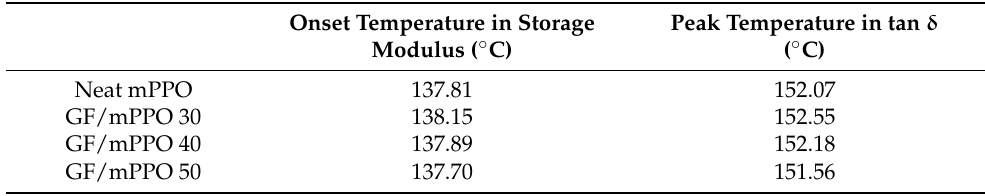
Table 5. Glass transition temperature determined by